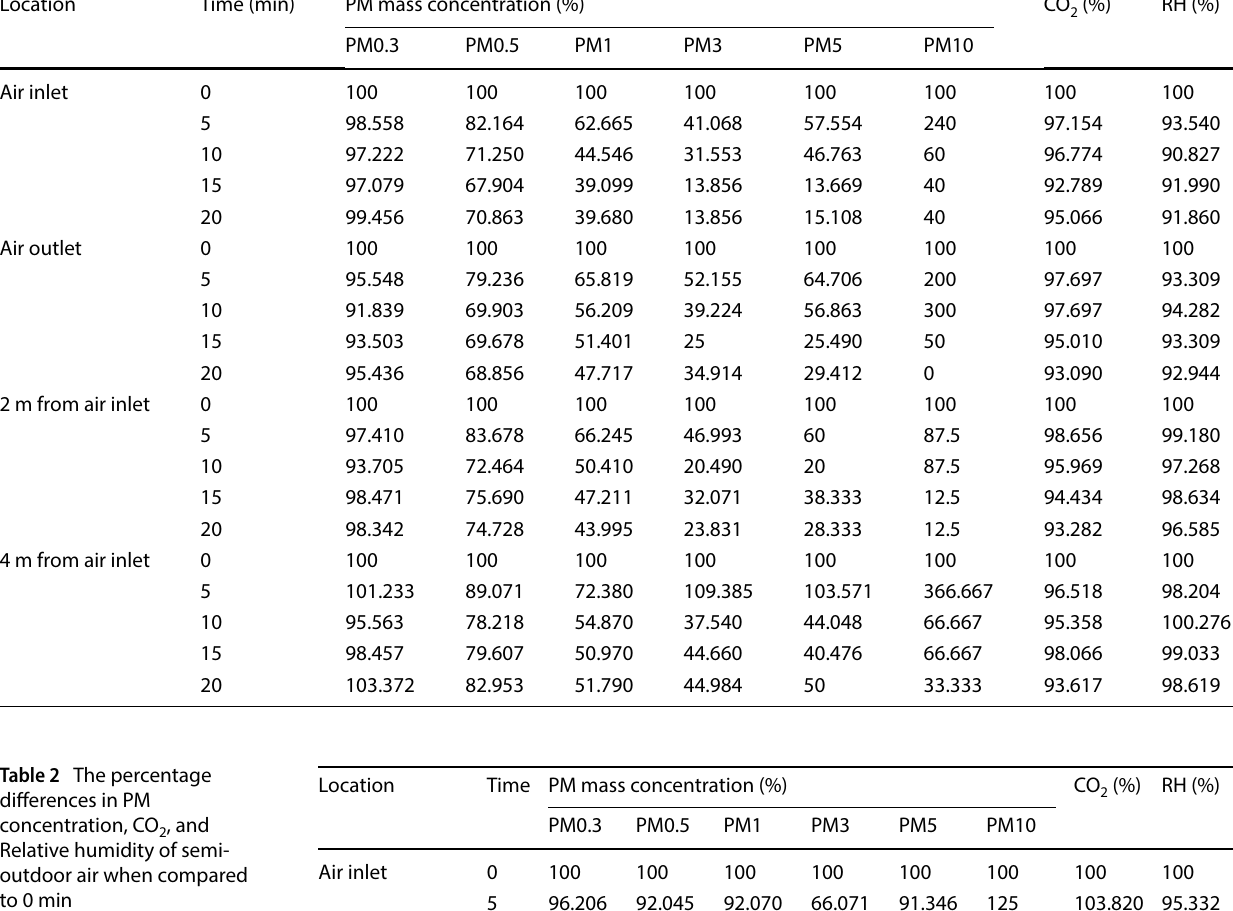
, and relative humidity of indoor air when compared to 0 min 2